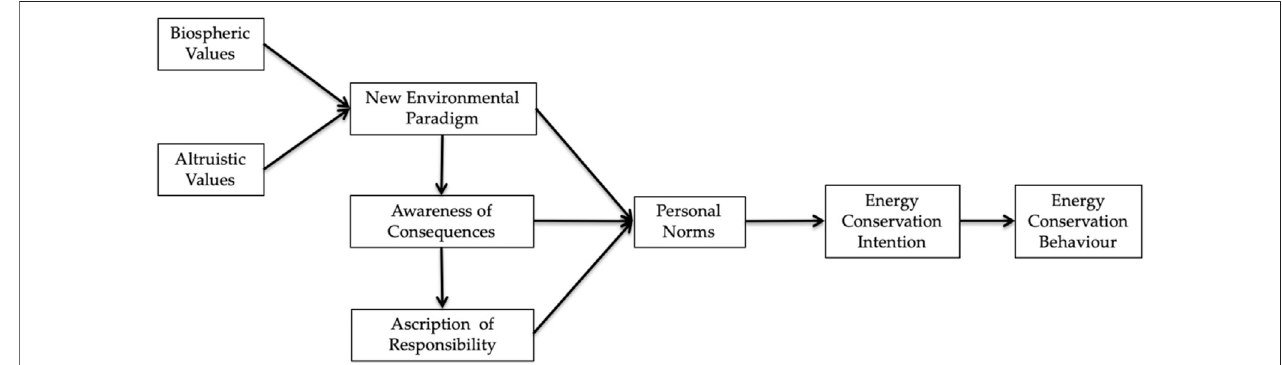
FIGURE 1 | Research